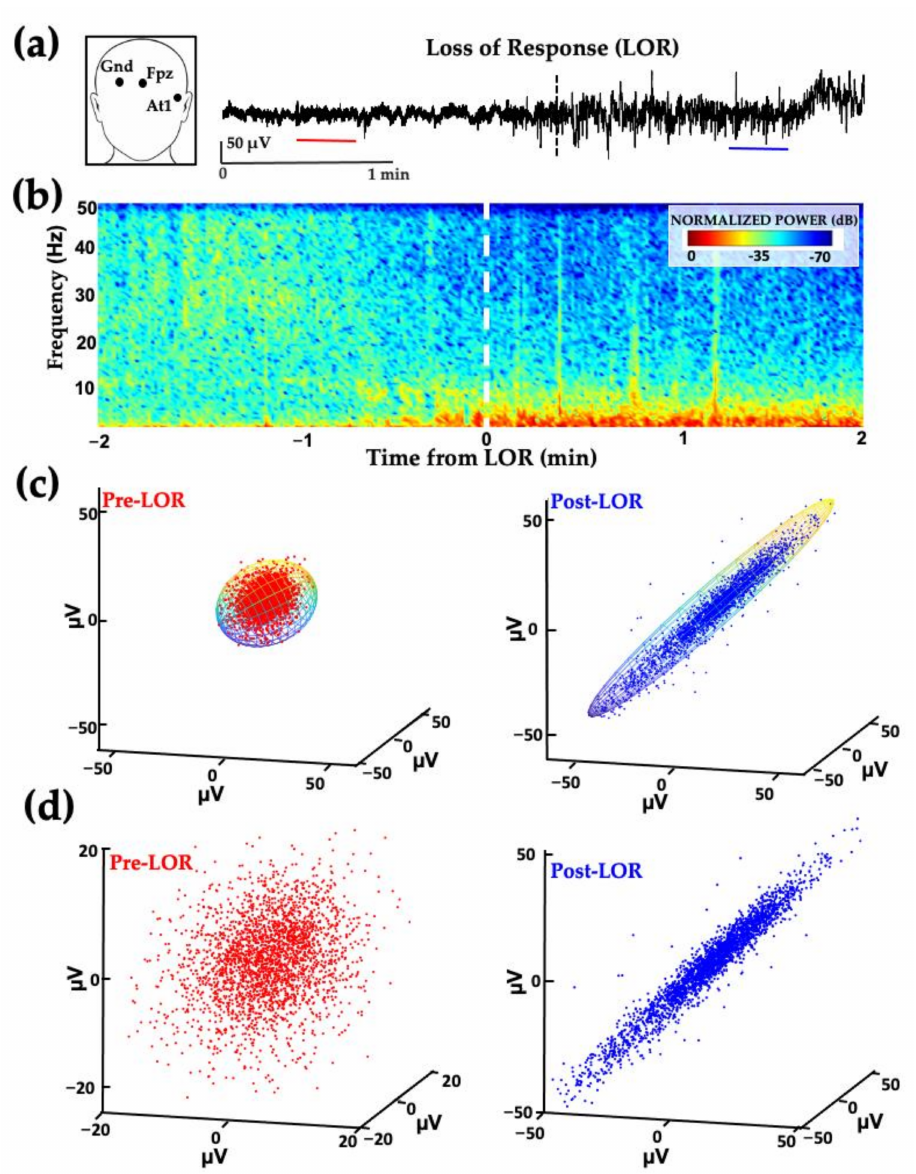
Figure 9. Example of patient EEG frontotemporal activity from before and after loss of response from remifentanil and nitrous oxide anesthesia. ( a ) EEG activity from electrode location At1 (inset) before and after loss of response (LOR, indicated with the dashed line) in patient anesthetized with a combination of remifentanil and 66% nitrous oxide (N 2 O). ( b ) Normalized spectrogram of EEG activity starting from 2 min before LOR to 2 min following LOR. ( c ) Attractors from 20 s EEG activity from patients before LOR (red, from red line shown in ( a )) to after LOR (blue, from blue line shown in ( b )) fitted with ellipsoid solid of revolution. Following LOR, a geometric shape change occurs where attractors become more ellipsoidal and flatten. ( d ) Same attractors from ( c ), auto-scaled to show geometric shape changes. Reproduced here with permission from Reference